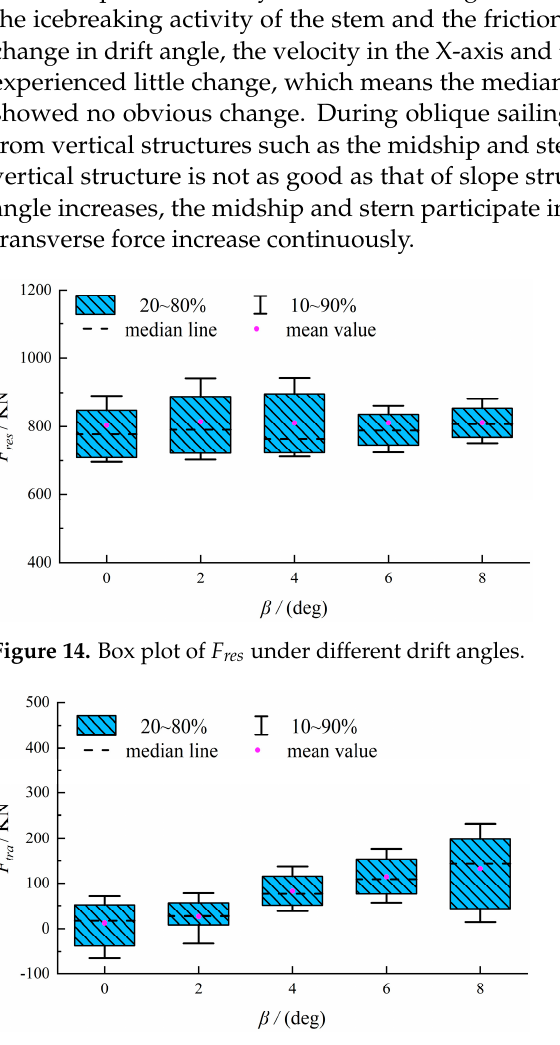
Figure 15. Box plot of F tra under different drift angles. Figure 16. Comparison of icebreaking under different drift angles. 6. Numerical Calculation of Ice Loads in Constant Radius Motion In a constant-radius maneuver, both drift angle and turning radius will affect the ice–hull interaction area. Hence, a constant radius maneuver was simulated to study the influence of drift angle and turning radii on ice loads at a speed of 6 knots, with 0.8 m of